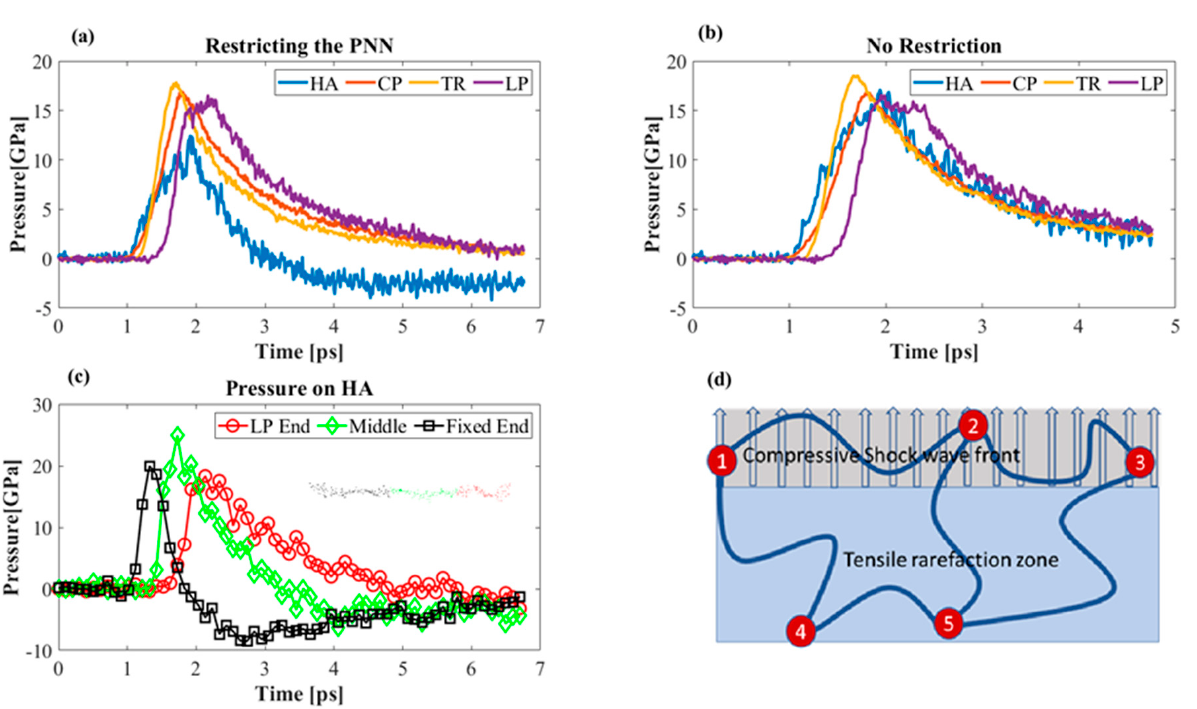
Figure 10. Pressure profiles of the PNN components. ( a ) Pressure on different PNN components without any restraint. ( b ) Pressure on various PNN components in the presence of boundary conditions. ( c ) Pressure at different locations of HA. ( d ) Schematic illustration of the PNN network structure.